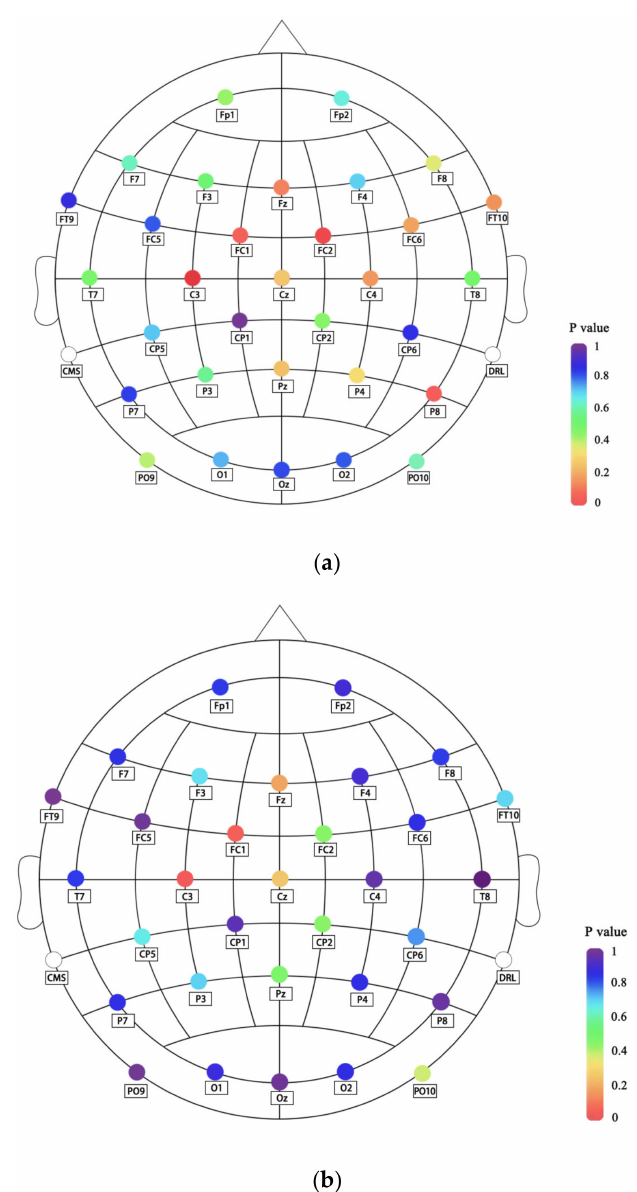
Figure 12. Significant brain dot distribution: ( a ) δ band and ( b ) β band. Table 7. β -band One-Way ANOVA